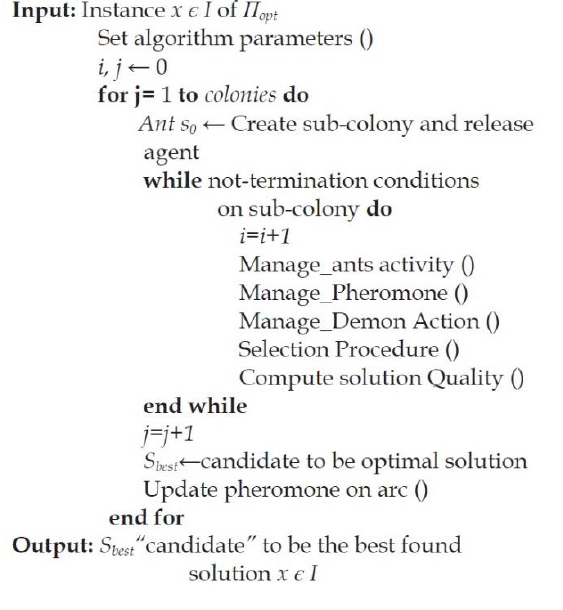
Figure 3. ACO pseudo